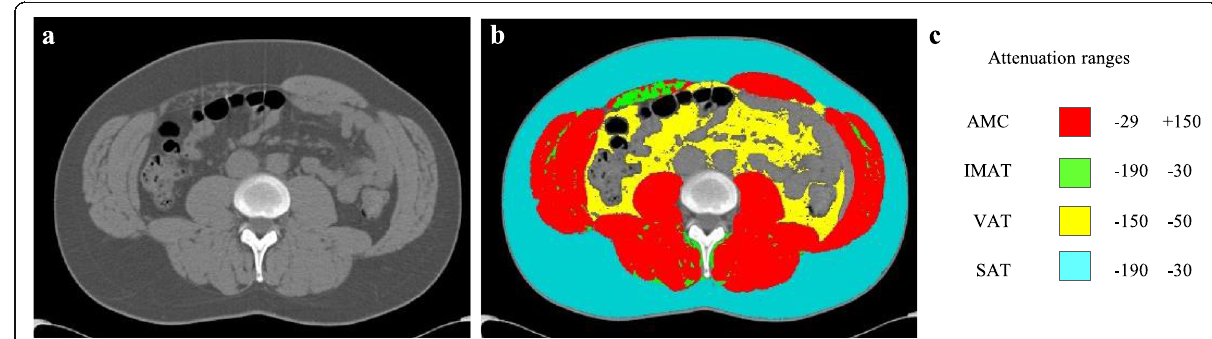
Fig. 1 Example of segmentation. Original computed tomography image ( a ). Segmented image ( b ). Attenuation ranges defined for each segmented tissue ( c